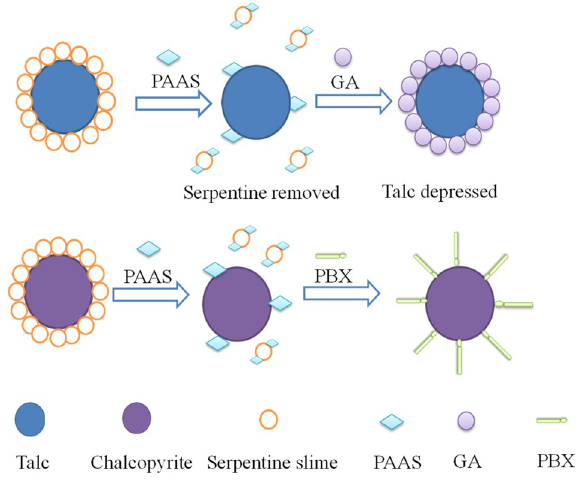
Figure 16. Depression mechanism of PAAS and GA.